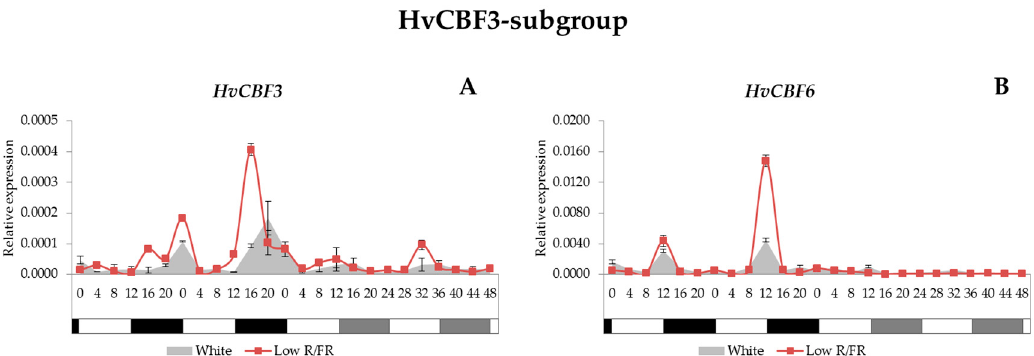
Figure 4. Gene expression patterns of the HvCBF3 and HvCBF6 ( A , B ) with white light and low R/FR ratio in the spectra. Conditions are the same as in Figure 1.